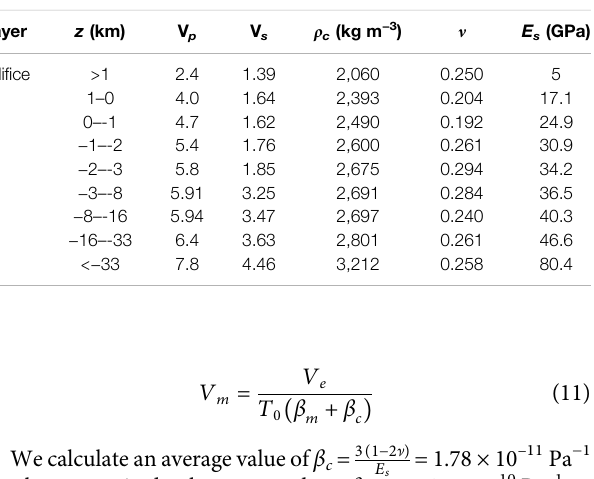
TABLE 2 | Mechanical properties assigned to subdomains in layered models based on seismic velocities (V p V s ).In theabsence oflocalseismicdata forthe edi fi ce and uppermost portions of the crust, data from Soufrière Hills volcano Young and Gottsmann (2015) are used for z > 1 km and from the Cascades Kiser et al. (2016) for 1 ≥ z ≥ − 3 km. Values for z < -3 km are derived from data presentedinSalahetal.(2014).TheplateausurroundingErciyesDa ğ isat z (cid:1) 0 km in the model, thus the edi fi ce extends to a height of 2,917 m. See Eq. 8 and Table 1 for further information on the derivation of the values.